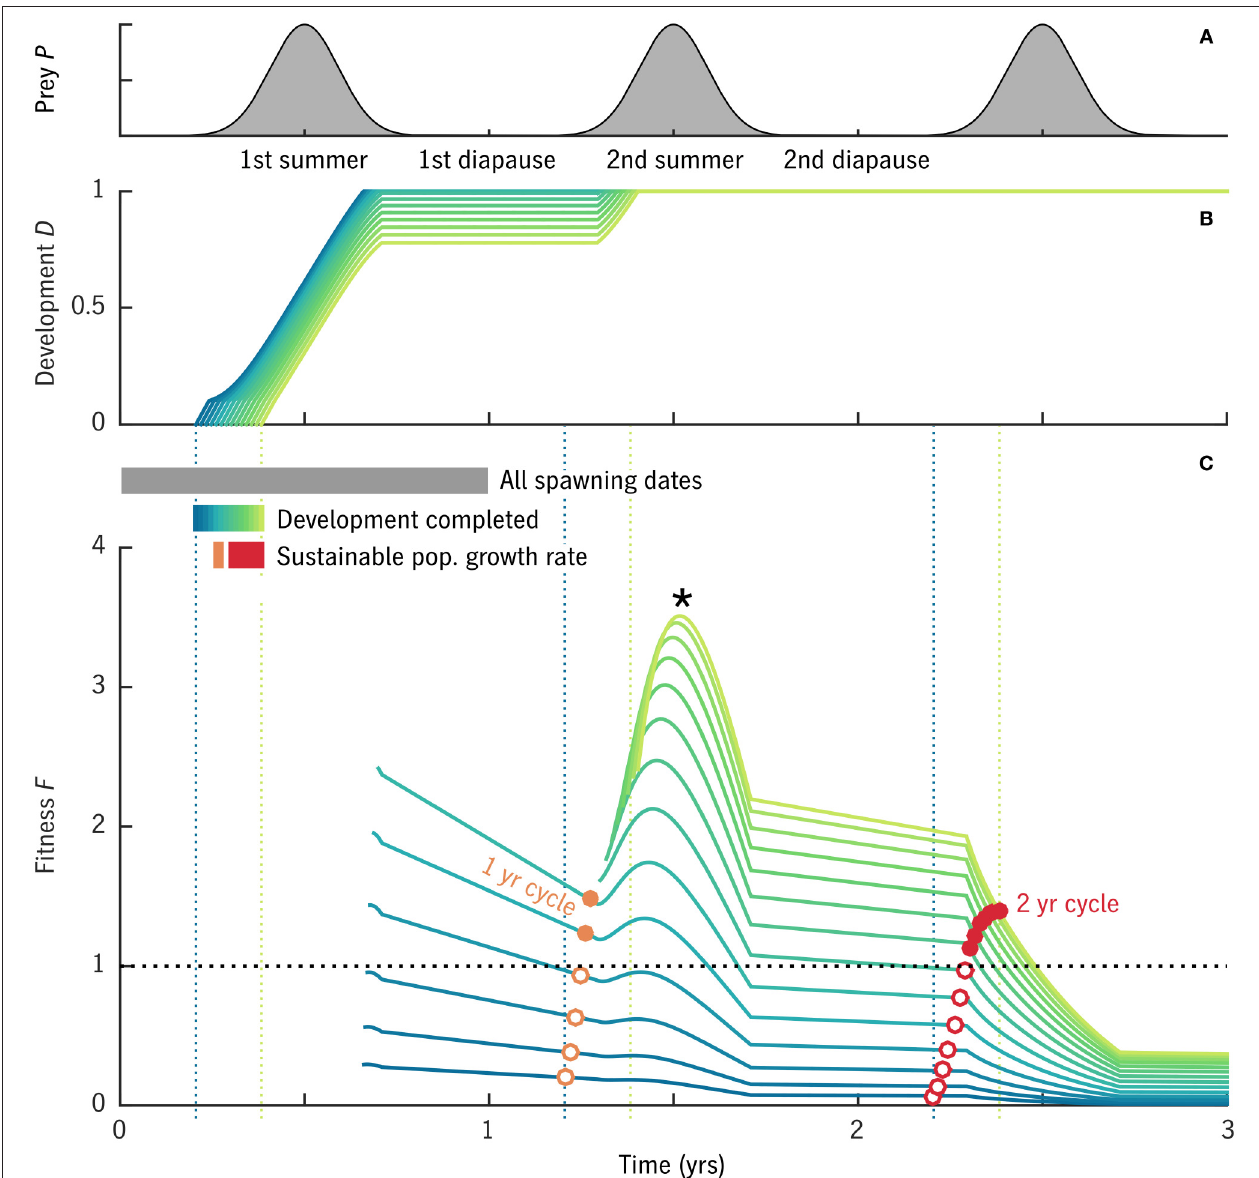
FIGURE 3 | Results of an example model case with u 0 = 0.007 d − 1 , T 0 = 1 ◦ C, and δ t = 135. Cohorts were simulated beginning from all spawning dates in year 1. (A) Prey availability over time. (B) Developmental stage D for cohorts that reach maturity ( D = 1) without starving: the blue–yellow color scale corresponds to spawning dates t 0 over the viable period from pre-bloom to bloom maximum. (C) Fitness F over time for the cohorts shown in (B) , i.e., the expected value (eggs egg − 1 ) of converting all free scope ϕ to eggs on a given date. Curves of F begin when maturity is reached ( D = 1) and egg production becomes possible. Open and solid circles mark the value of F on the 1-year (orange) and 2-year (red) anniversaries of the original spawning date. Solid circles mark cohorts that achieve a fitness above the replacement